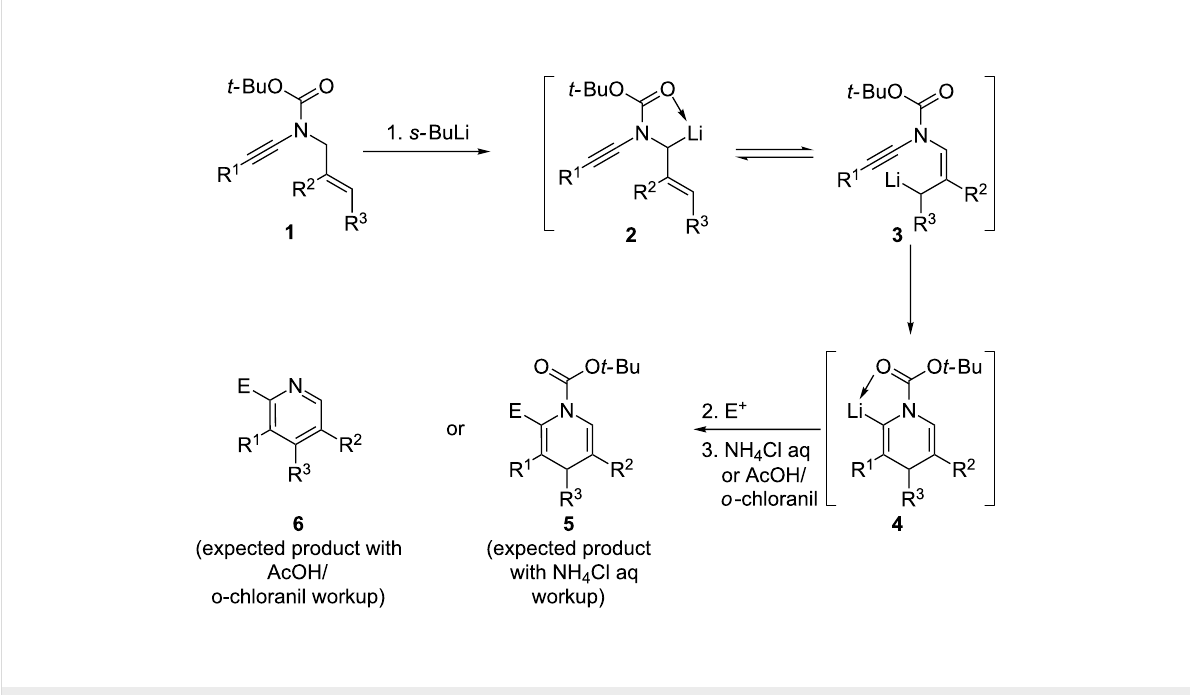
Scheme 1: Strategy for the synthesis of (1,4-dihydro)pyridines by deprotonation/intramolecular